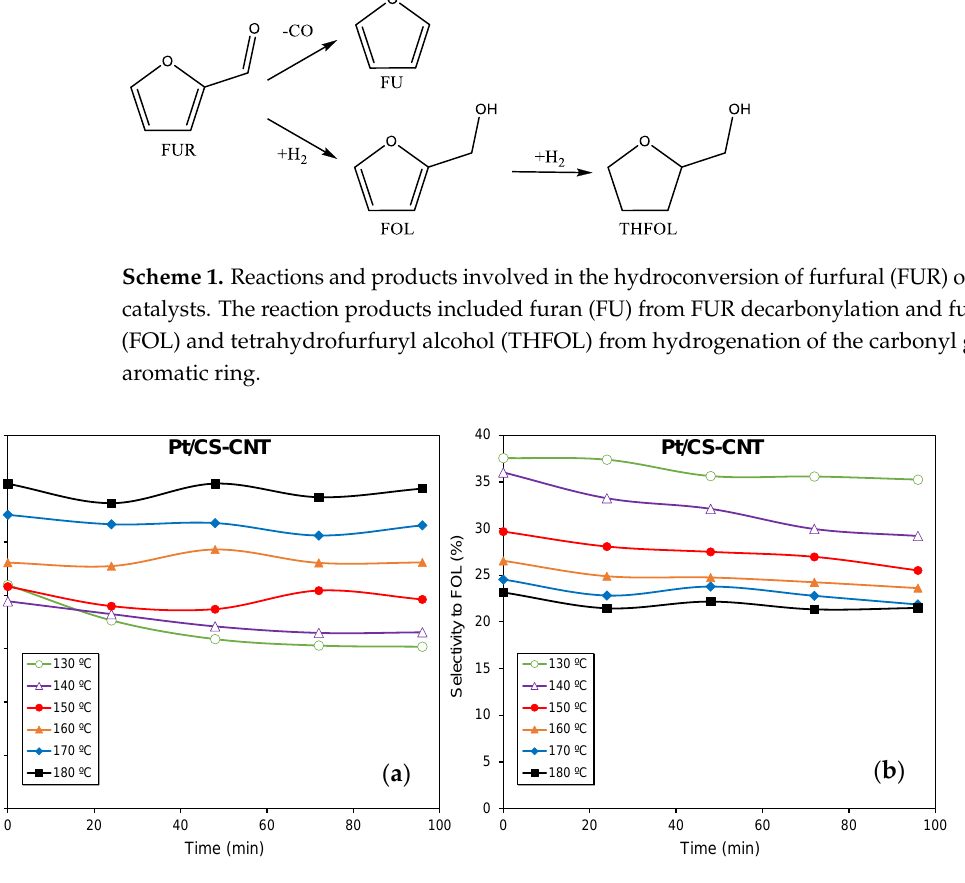
Figure 7. Catalytic performance as a function of reaction temperature over all Pt/carbon catalysts: ( a ) conversion of FUR and ( b ) selectivity to FOL.